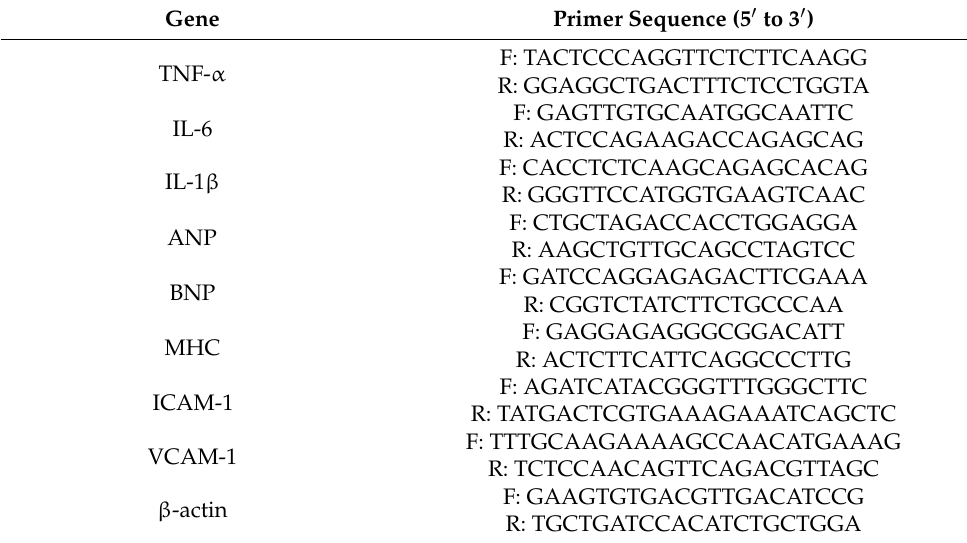
Table 2. Sequences of primers used in the gene expression analysis.